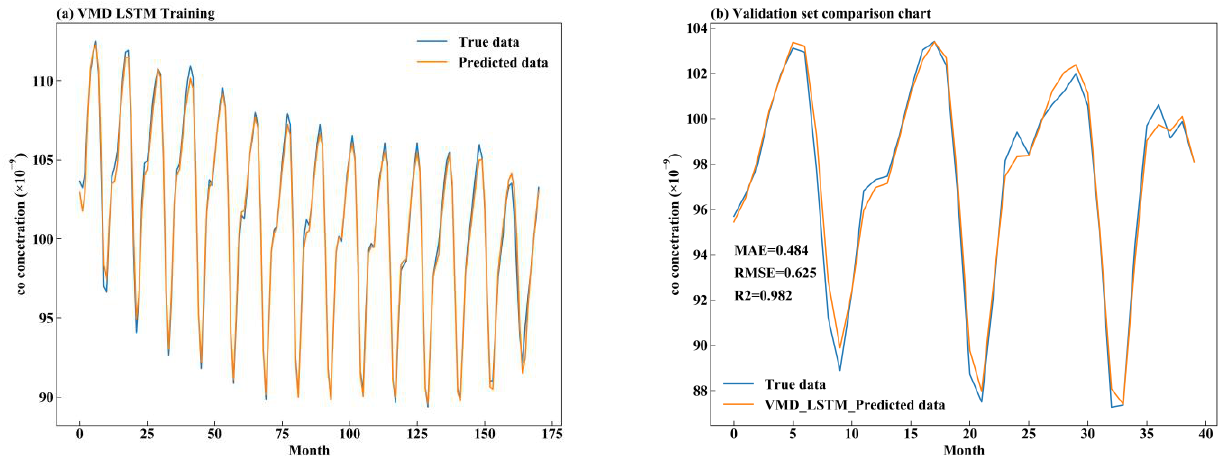
Figure 17. Comparison diagram of real value and predicted value of training set and verification set based on VMD-LSTM model. ( a ) Training set comparison chart; ( b ) Verification set comparison chart.